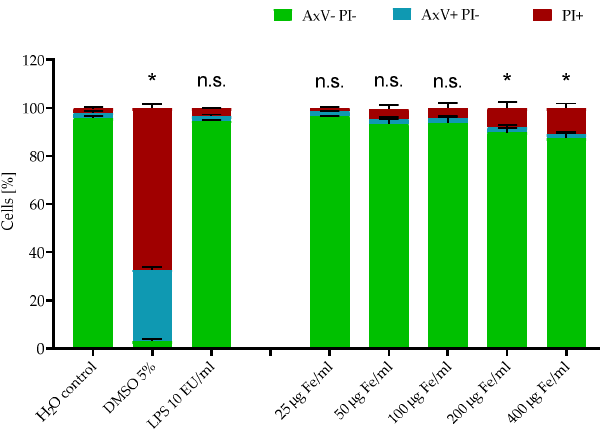
not significant (n.s.).